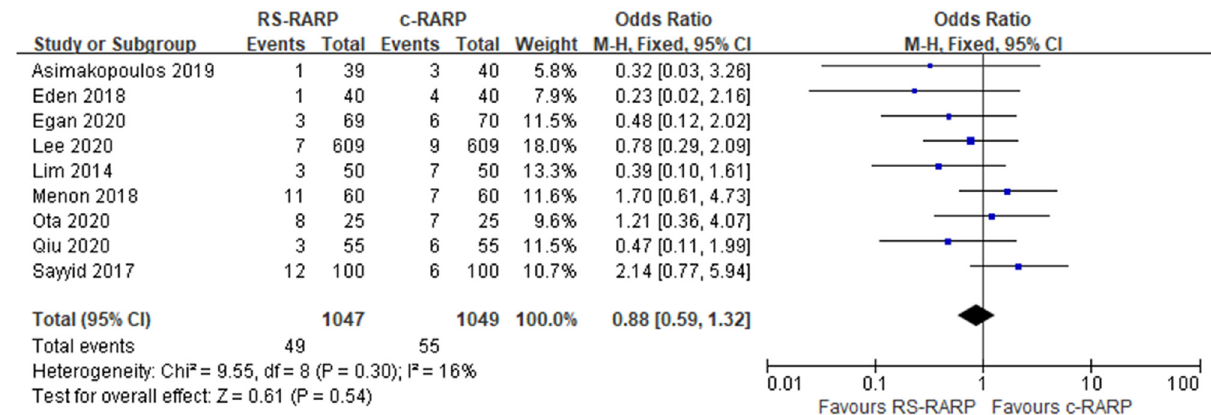
FIGURE 8 | Forest plot of complications.